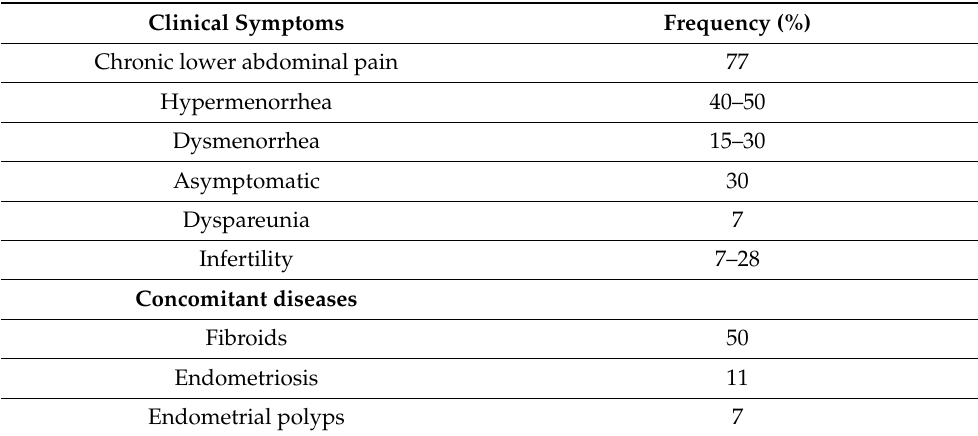
Table 1. Clinical symptoms, concomitant diseases and their frequency in adenomyosis